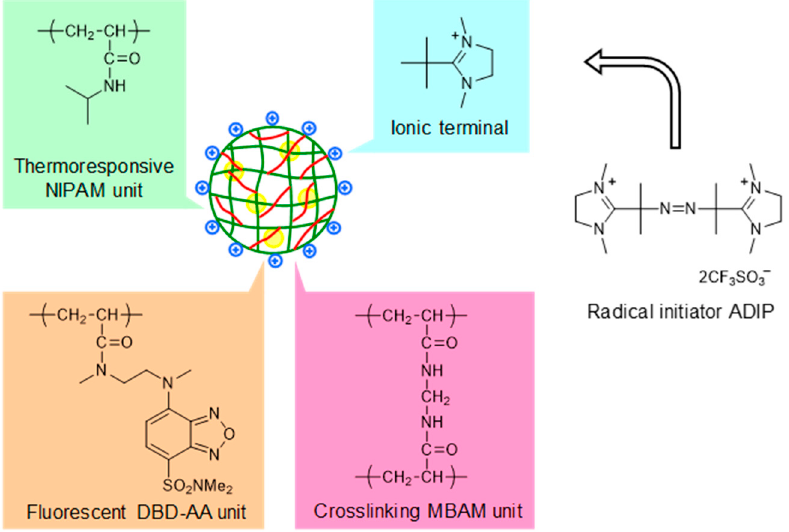
Figure 1. Cationic fluorescent nanogel thermometer prepared with cationic radical initiator ADIP (2,2’-azobis-[2-(1,3-dimethyl-4,5-dihydro-1 H -imidazol-3-ium-2-yl)]propane triflate). NIPAM: N - isopropylacrylamide, DBD-AA: N -{2-(7- N , N -dimethylaminosulfonyl-2,1,3-benzoxadiazol-4- yl)methylamino}ethyl- N -methylacrylamide, MBAM: N , N